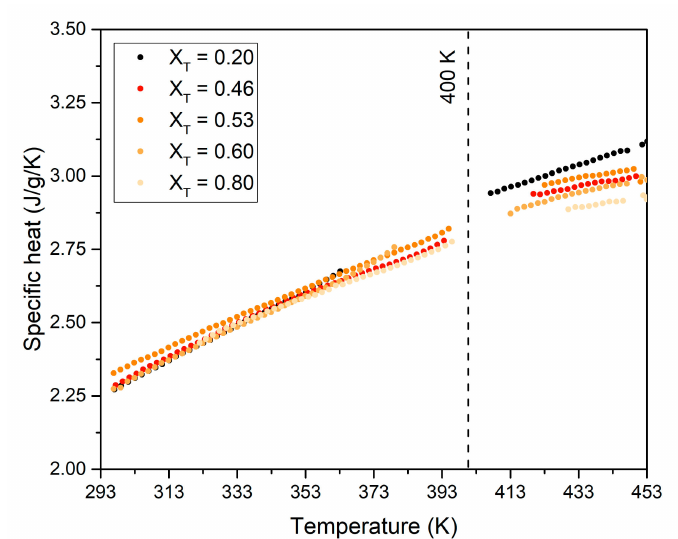
Figure 7. Specific heat as function of temperature for the liquid phase of di ff erent NPG-TRIS mixture (0.2 to 0.8 mole fraction of TRIS). The data at temperatures above 400 K represent the specific heat of stable liquid phase, whereas those below 400 K correspond to metastable liquid phase achieved during cooling.